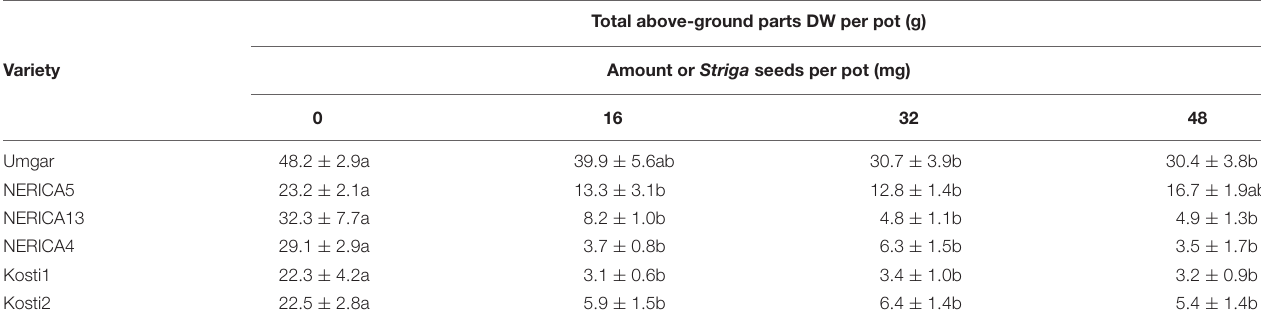
Data are mean ± standard error of six replications. Means within a variety followed by a common letter are not significantly different by Tukey’s HSD test (p < 0.05).